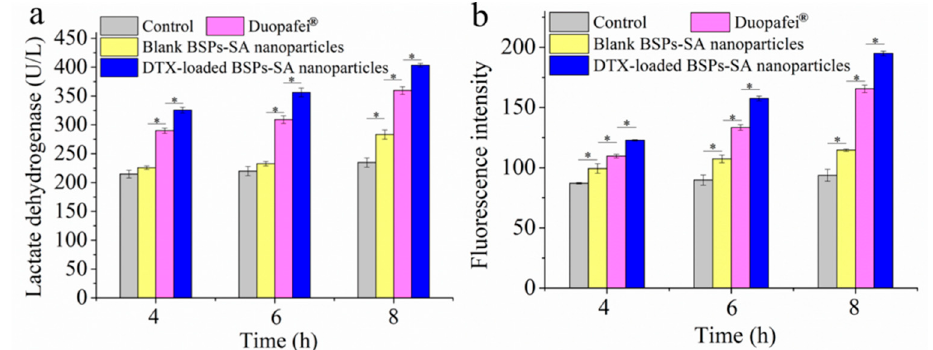
Figure 8. Lactate dehydrogenase release assays ( a ) and the mean fluorescence intensity of reactive